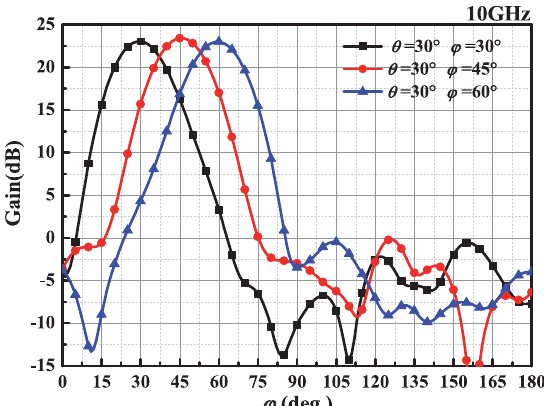
Fig. 14. The gain curve of different azimuth angle transmission antennas at 10 GHz.